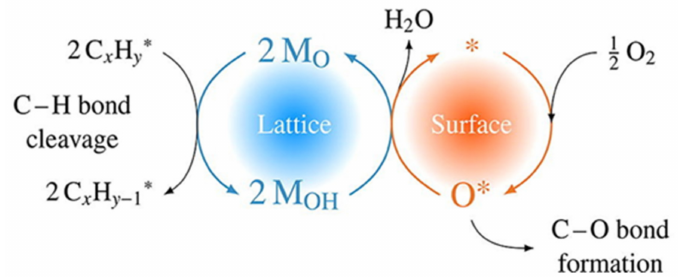
Figure 14. The catalytic cycle for the ODHE reaction on MoVTeNb mixed metal oxides proposed by Donaubauer et al. Adapted from ref. [107], Copyright (2020), with permission from